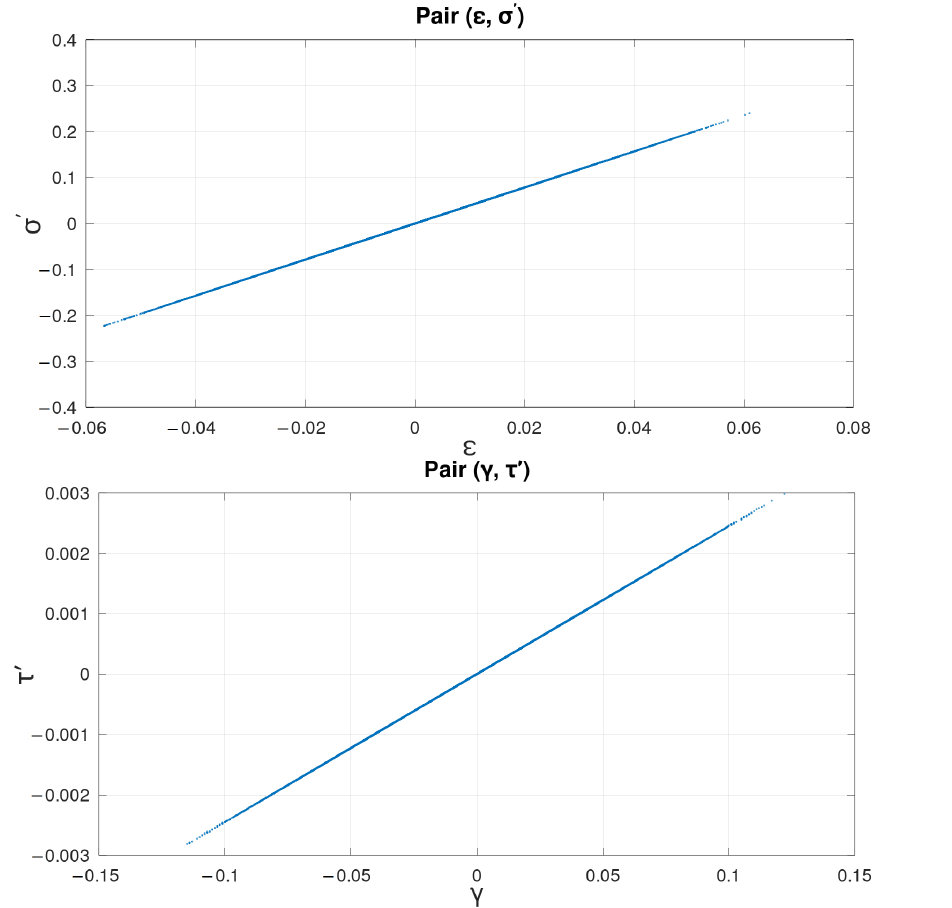
Figure 2. Virtual inflation of the neo-Hookean membrane (26). Top: ( (cid:101) , σ (cid:48) ) pair; bottom: ( γ , τ (cid:48) )